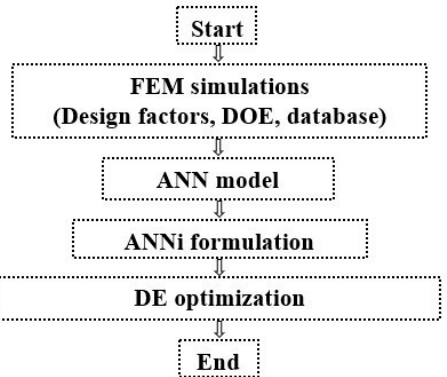
Figure 1. Activity flow diagram for methodology developed. The optimal value for MVMS was set to 19 × 10 −3 . To satisfy this condition, only the value of SP was considered as design factor, whereas the screw geometry was constant, according with a commercial screw-plate absorbable system dimension.